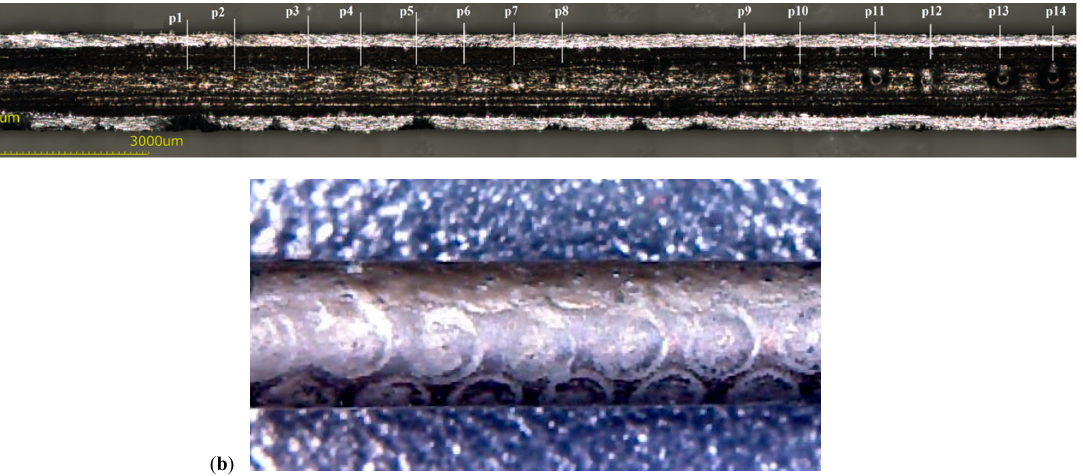
Figure 1. ( a ) View of the inner surface of the wall after exposure to laser pulses of different powers.